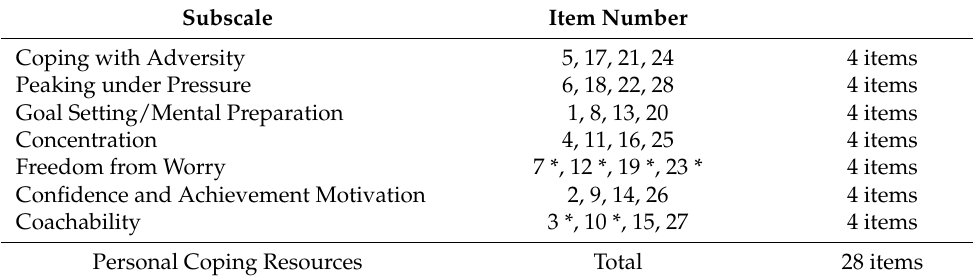
Table 4. The Athletic Coping Skills Inventory-28